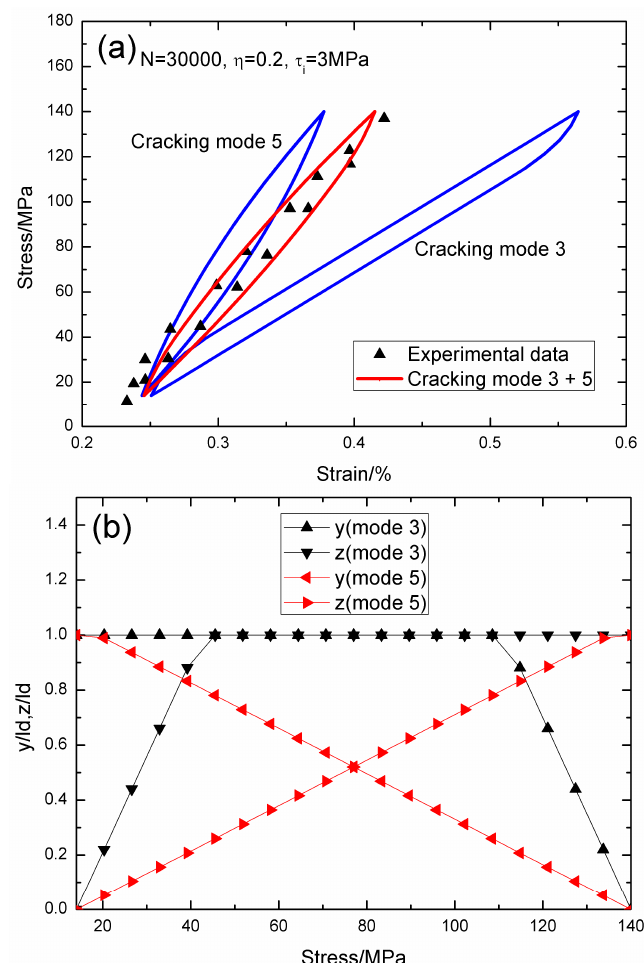
Figure 16. ( a ) The theoretical and experimental hysteresis loops; and ( b ) the interface slip lengths, i.e. , y / l d and z / l d , of matrix cracking modes 3 mode 5 of 2D woven SiC/SiC composite under σ max = 140 MPa at 1200 °C in steam and a loading frequency of 1.0 Hz when N = 30,000.